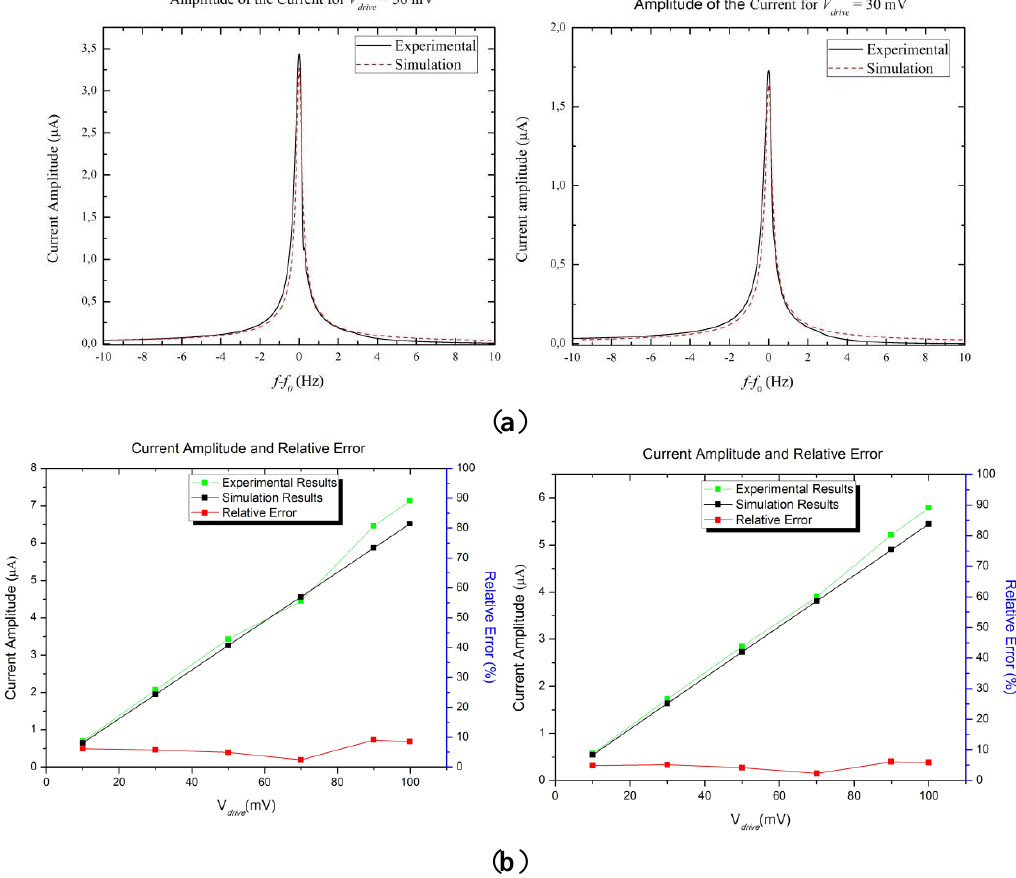
Figure 5. ( a ) Amplitude of the current for two QTFs for V respectively. ( b ) Current peaks at the resonance frequency and relative error between experimental and numerical data.